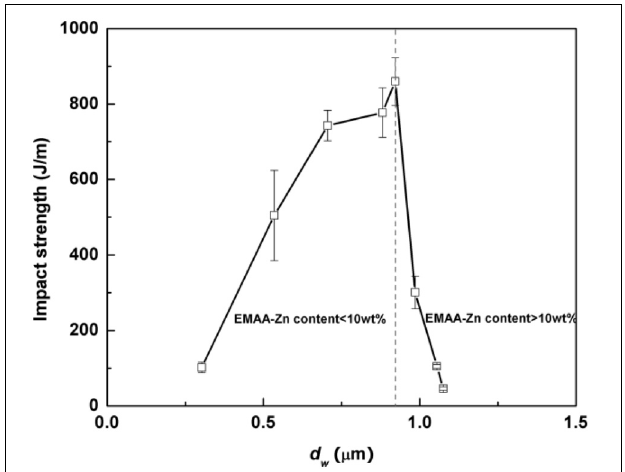
FIGURE 22 | Izod impact strength of PLA/EBA-GMA/EMAA-Zn (80/20-x/x) blends with total content of both modifiers fixed at 20wt% as a function of weight-average particle diameter (dw). Adapted with permission from Liu et al.